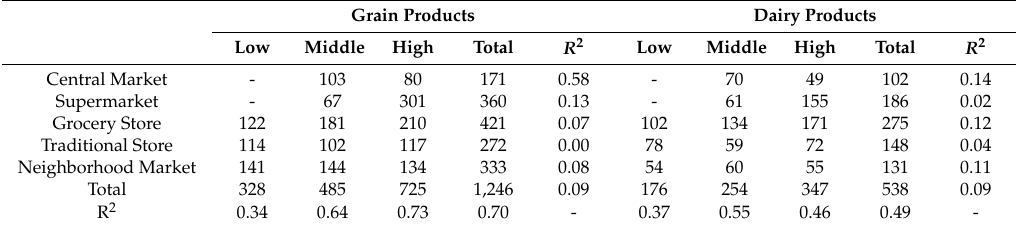
Table 2. Availability of grain and dairy products by neighborhood and outlet types. (Source: Inventory dataset (2016), as computed by the authors. The coefficient of determinant, R 2 , indicates the percentage of variance of product availability in an outlet type (neighborhood type) that neighborhood type (outlet type) explains. The t-tests indicate greater product availability in supermarkets than at any traditional retail outlets and high-income neighborhoods at the 1% level of